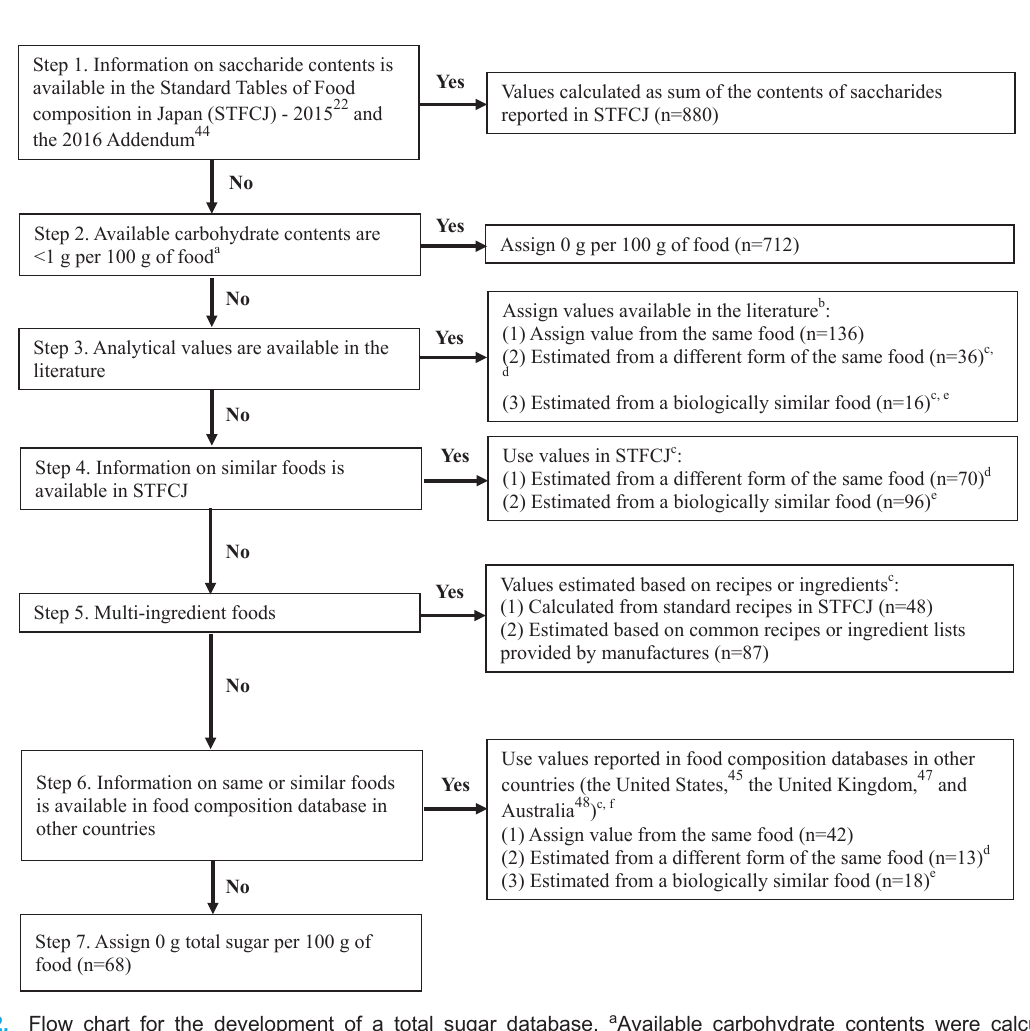
Figure 2. Flow chart for the development of a total sugar database. a Available carbohydrate contents were calculated as subtracting dietary fi ber content (g / 100g of food) from carbohydrate. b A search strategy for the literature is described in online supplement. c Values were adjusted using the ratio of the dry weight between interested and referred food items. d Total sugar content of the cooked or dried food was calculated from the raw form. e Values from a similar